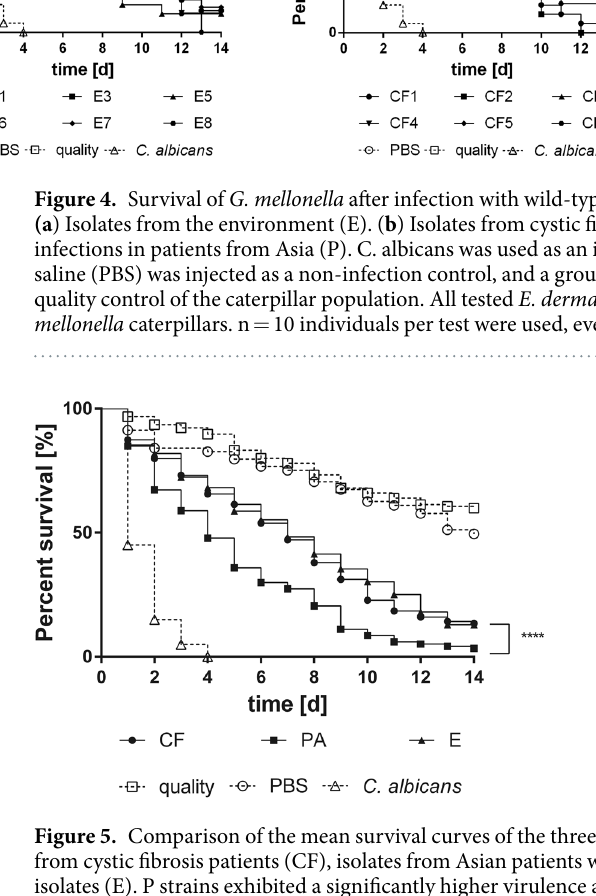
5 SCIENTIfIC REPORTS | (2018) 8:12747 | DOI:10.1038/s41598-018-30909-5